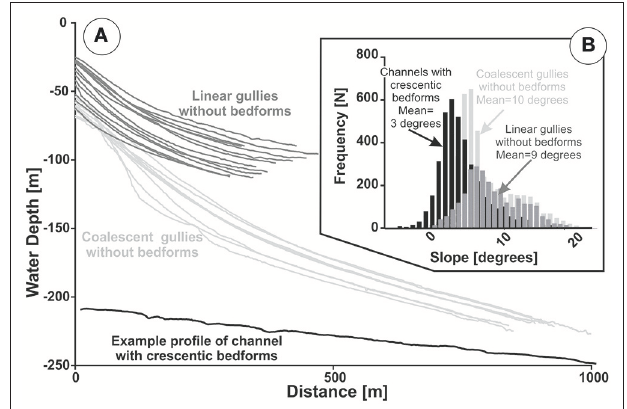
FIGURE 6 | Isolated linear gullies are much shorter in length than coalescent gullies, but attain similar slope angles, which are higher on average than those for channels with crescentic bedforms (A) . Local slope measurements along all mapped gullies and channels (B) shows that channels with crescentic bedforms only occur at much lower slope angles (mean of 3